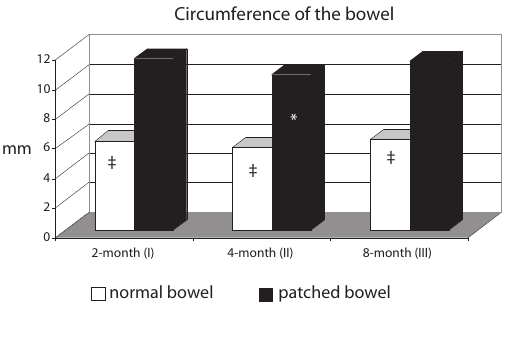
Four month specimen. Flap was fully covered by neomucosa consisting of irregular branching villi, which overlaid smooth muscle and fibrous tissue. Arrow shows omentum attaching to the flap (HE × 10).